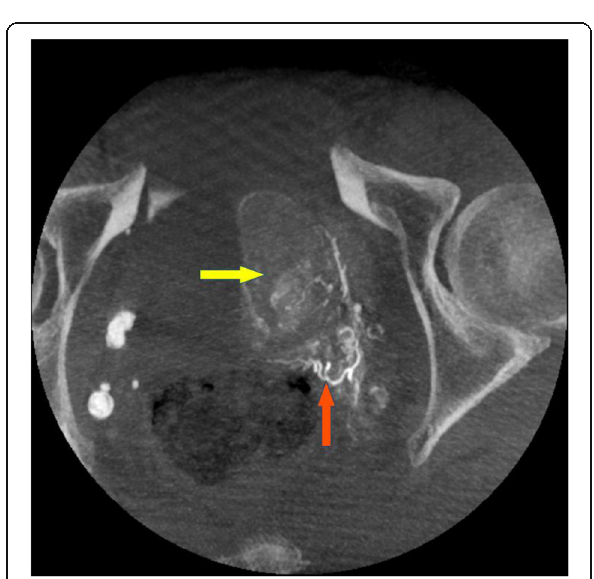
Fig. 4 Distal CBCT. Ten millimeters MIP axial view from a super- selective CBCT showing prostatic blush (yellow arrow) as well as rectal branch (orange arrow) originating from a prostatic artery, observed after vasodilator injection. The catheter had to be repositioned to avoid off-target